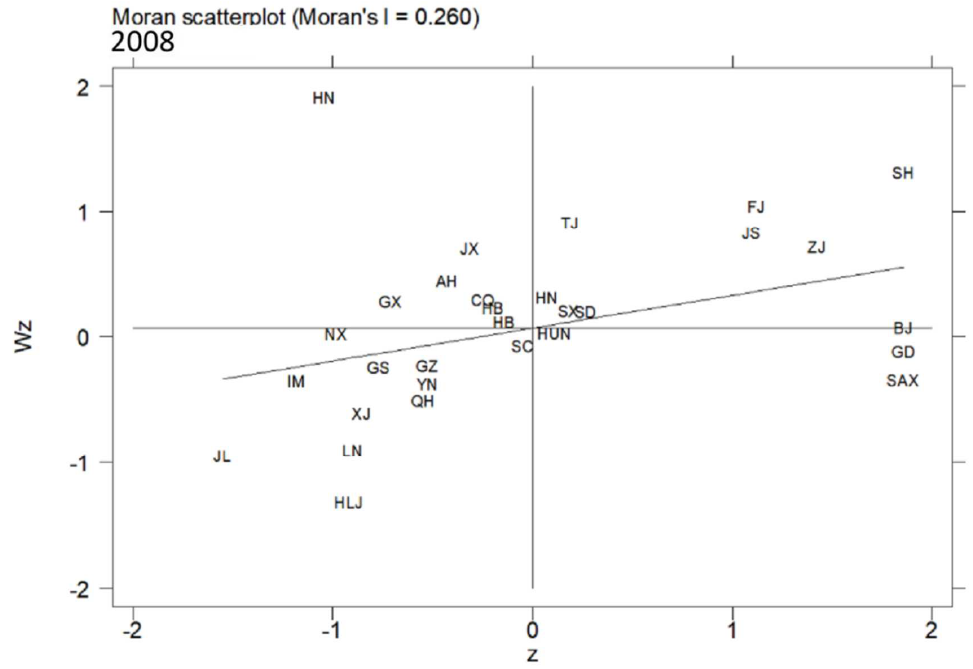
Figure 5. MSP map of ULGLE in 30 provinces in 2008.